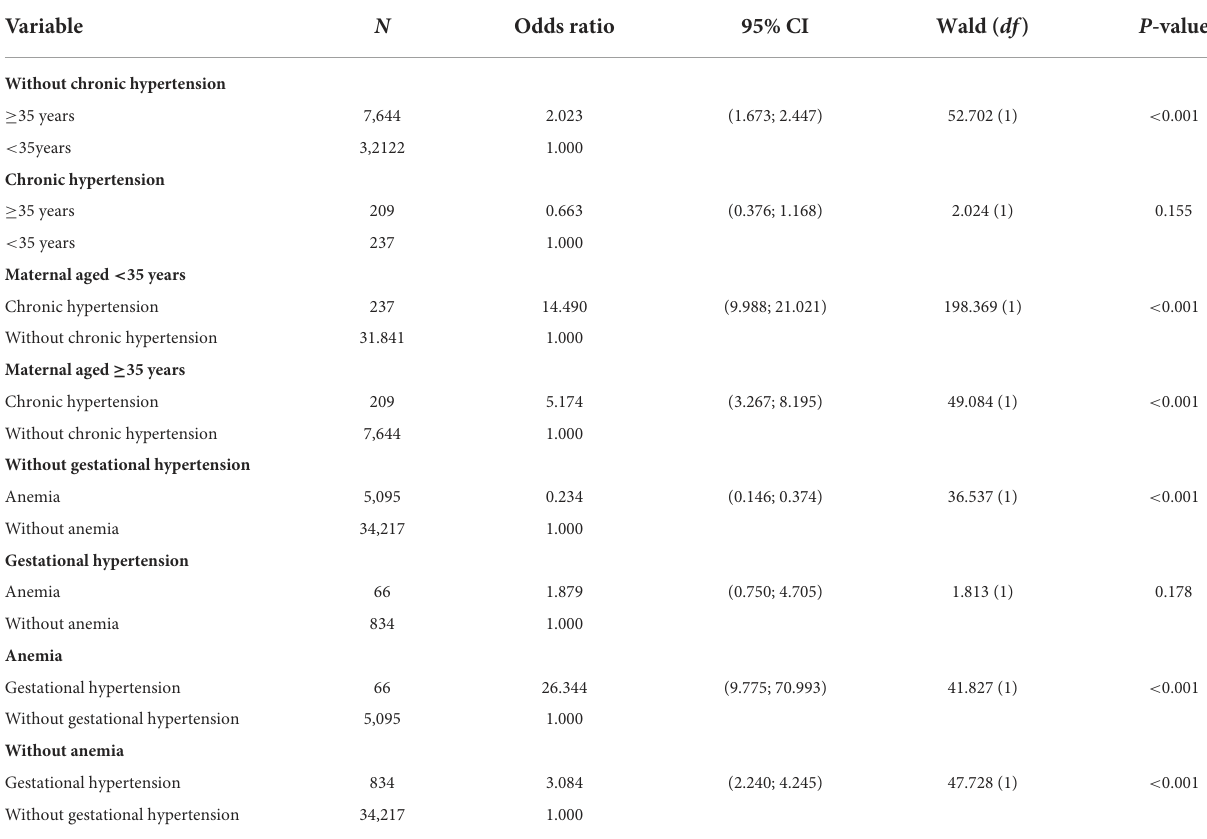
TABLE 3 Selected model analysis for preeclampsia factors with interaction.